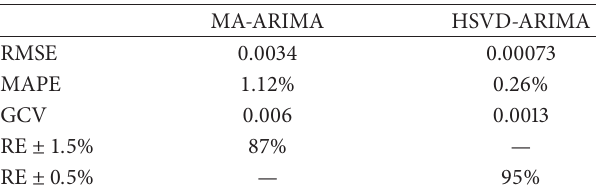
Table 1: Forecasting with